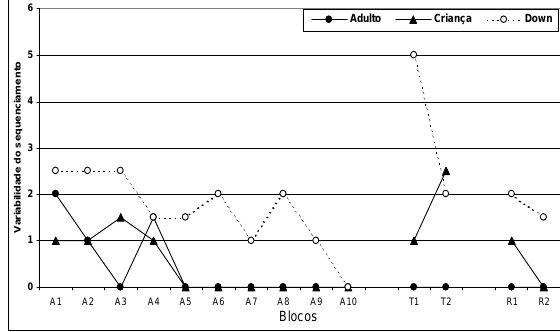
Figura 5 . Mediana da variabilidade do tempo relativo de pausa ao longo das fases para os três grupos